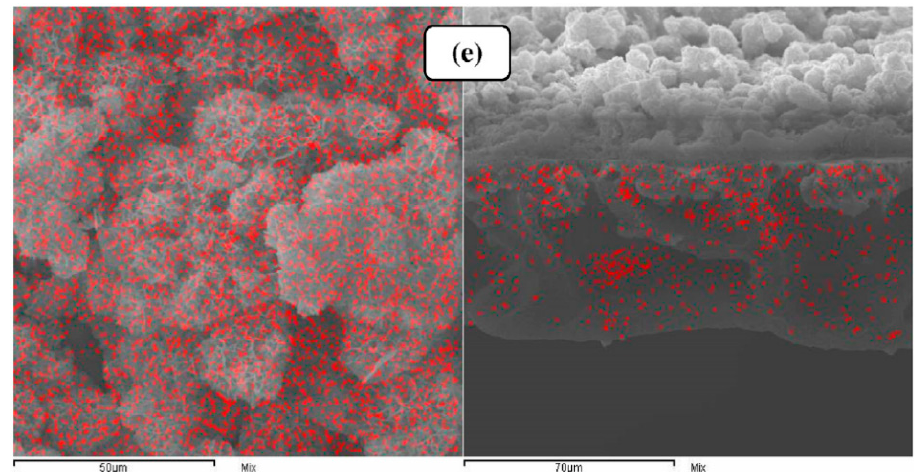
Figure 4. Energy Dispersive X-Ray ( EDX) mapping of Zn element in the cross-section of the ZIF-8/PVDF composite membranes prepared at different contact times of ( a ) 1 h and ( b ) 3 h; EDX mapping of Zn element on the surface and cross section of the ZIF-8/PVDF composite membranes prepared at contact times of ( c ) 5 h, ( d ) 8 h and ( e ) 24 h [100].